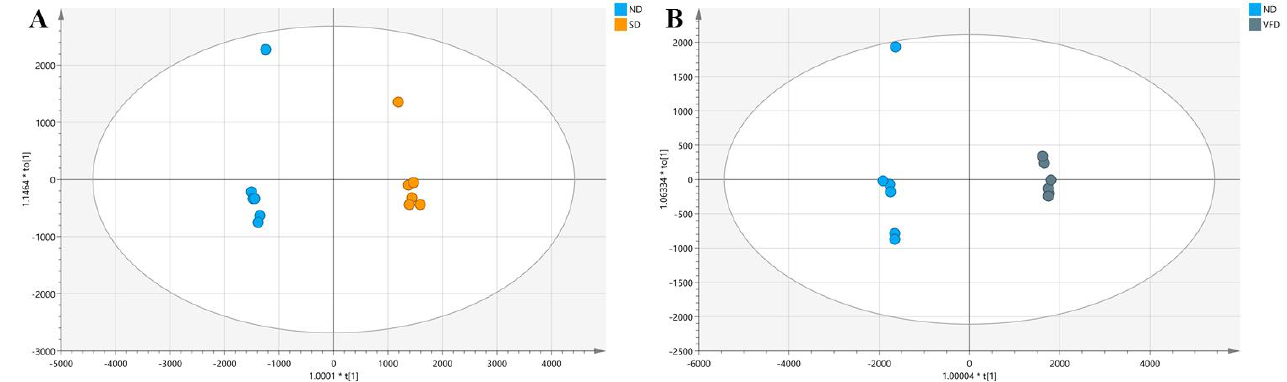
Figure 3. The OPLS − DA scores plot: ( A ) comparison between natural drying (ND) and sunlight drying (SD), ( B ) comparison between ND and vacuum freeze drying (VFD); ( n = 6).